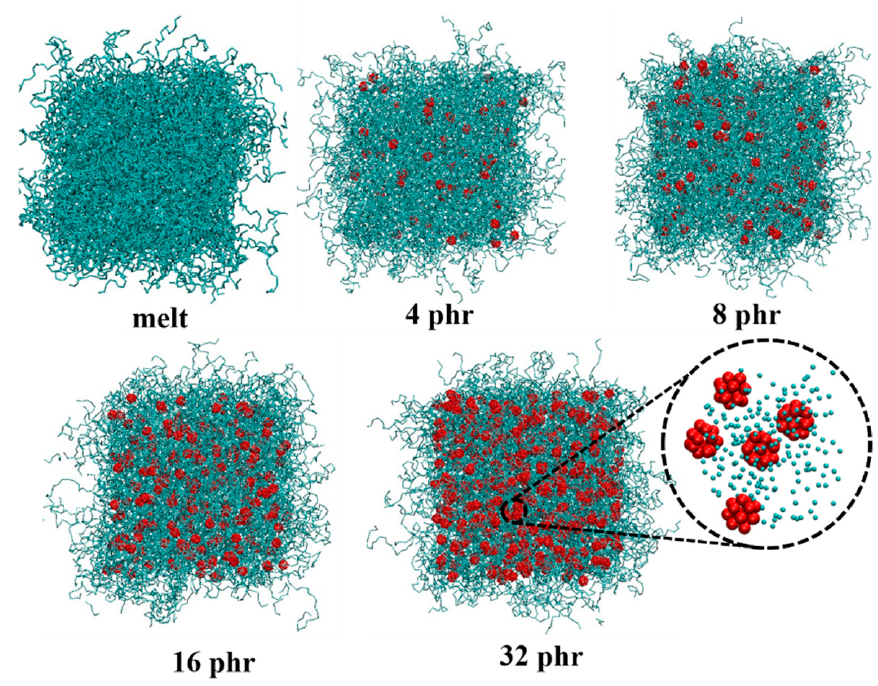
Figure 3. Snapshots of cis -PI-C 60 composites at different C 60 concentrations from 0 (melt) to 32 phr. Cyan and red represent cis -PI and C 60 , respectively.